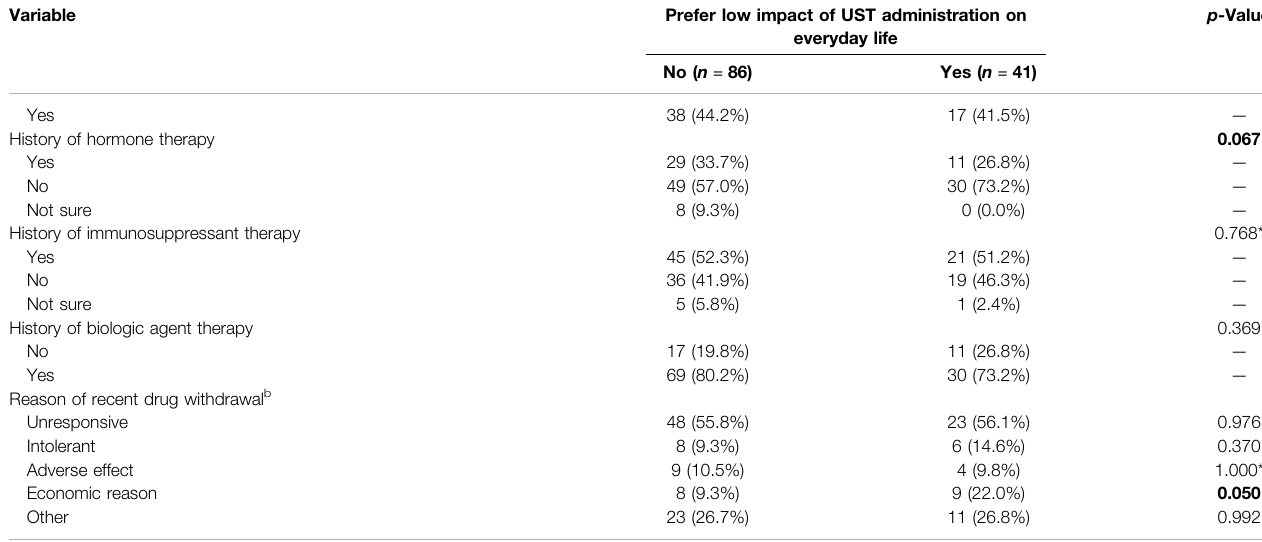
TABLE 8 | ( Continued ) Characteristics of participants with different preference toward impact of UST administration on everyday life.